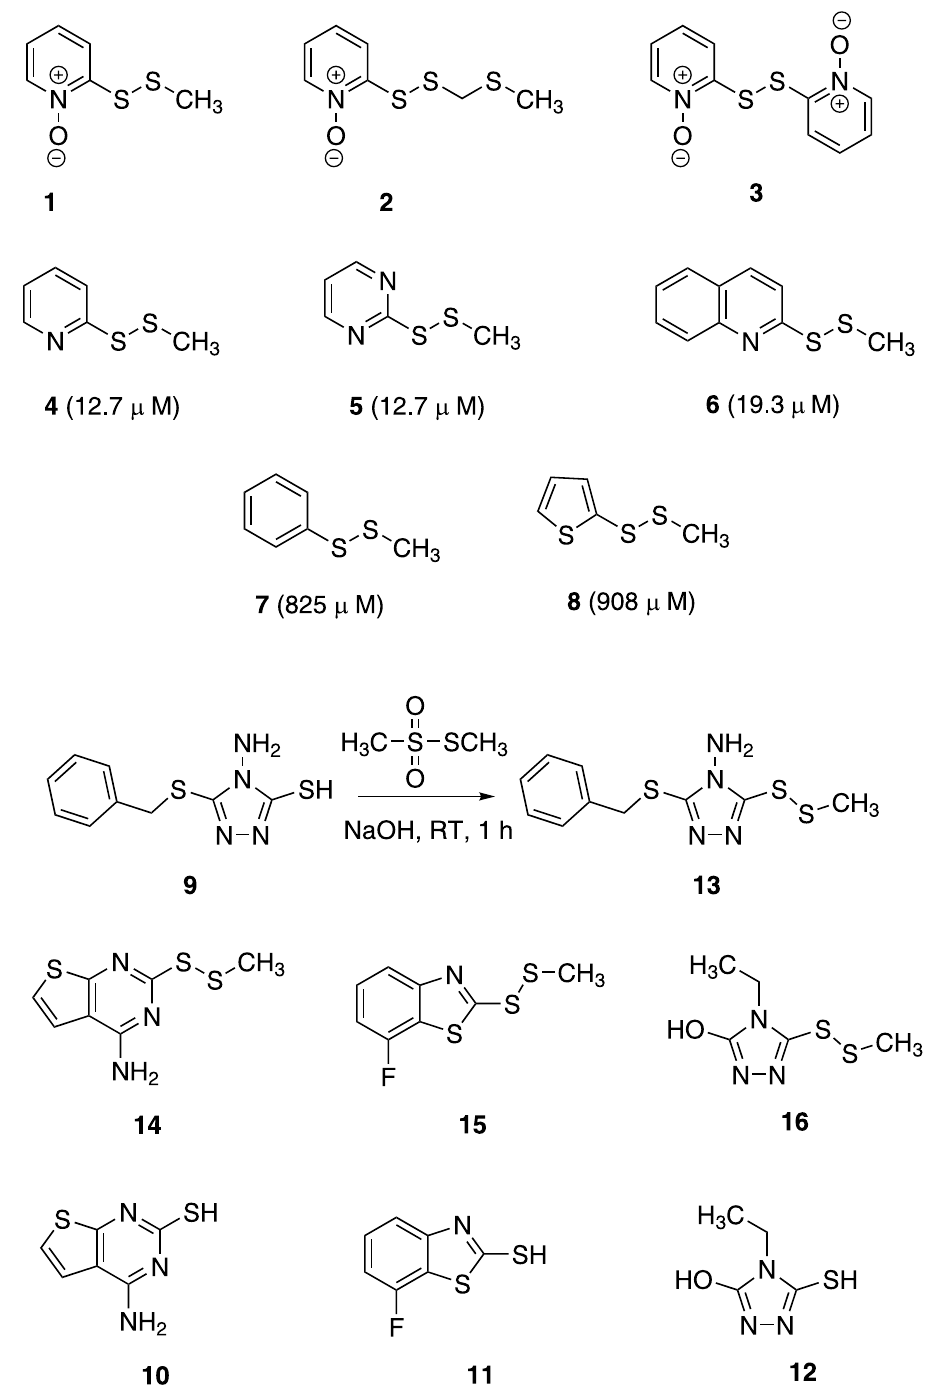
Figure 1. Compounds isolated from Allium stipitatum with antibacterial activity ( 1 – 3 ). Synthesized compounds ( 4 – 8 ) based on the natural products. MIC values against S . aureus are in parentheses. Reaction scheme for the synthesis of compounds ( 13–16 ) and the resulting synthesized methyl